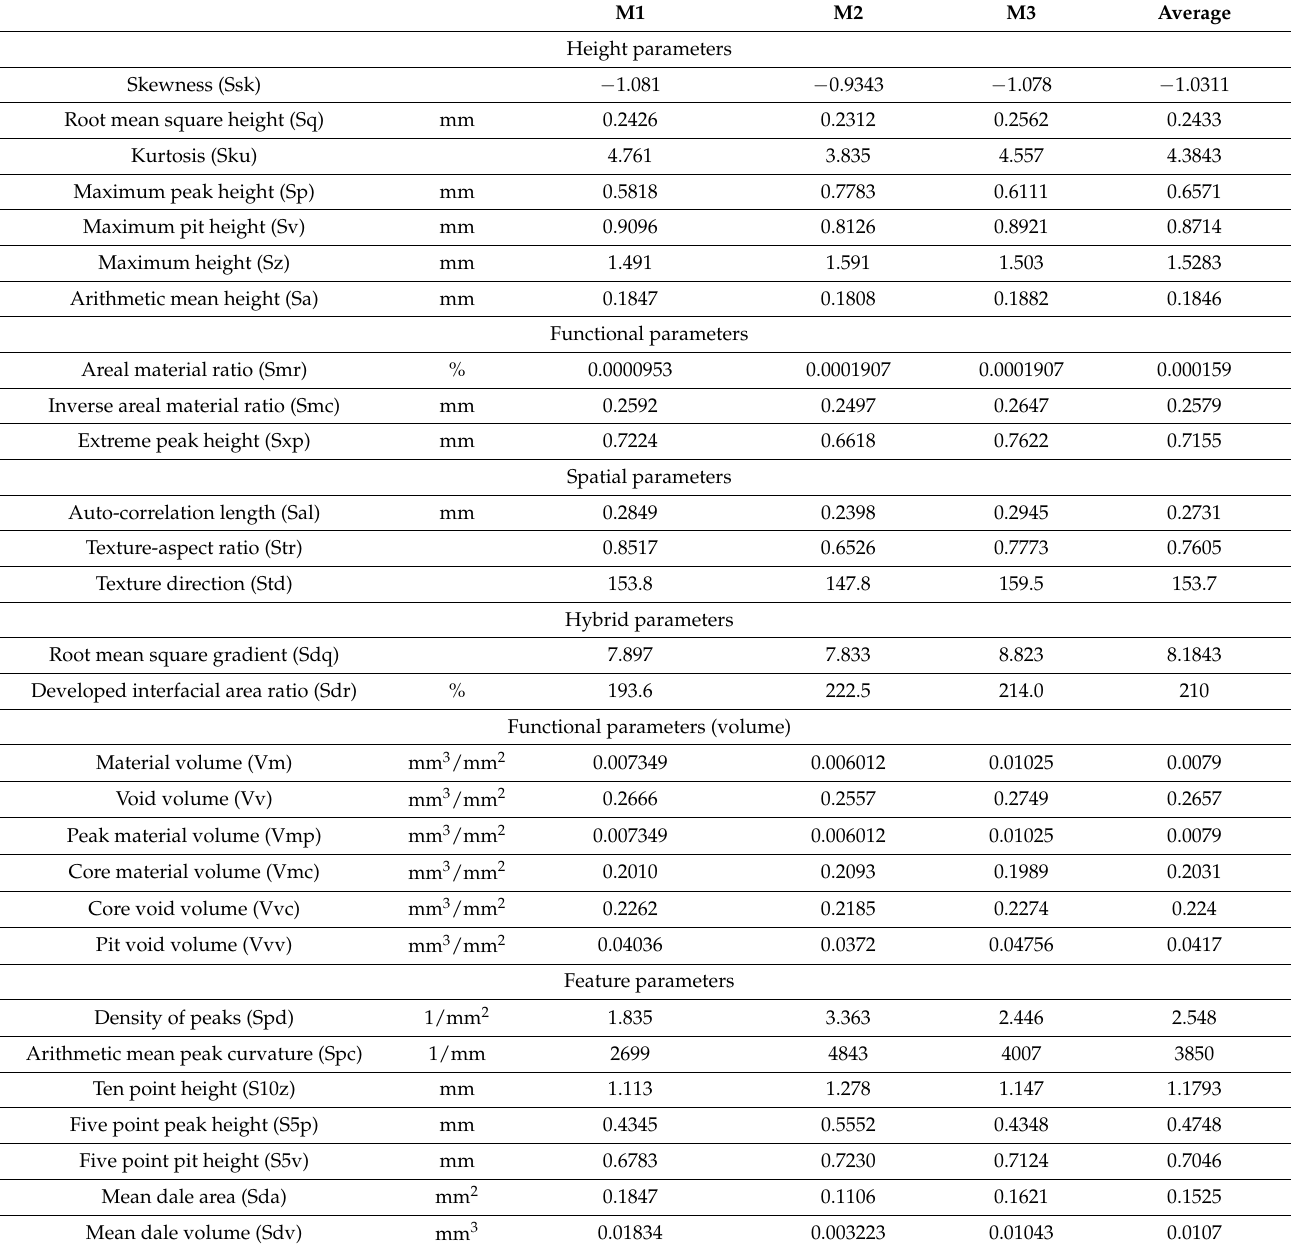
Table 7. Stereometric parameters obtained as a result of the analysis of images obtained with the use of a confocal